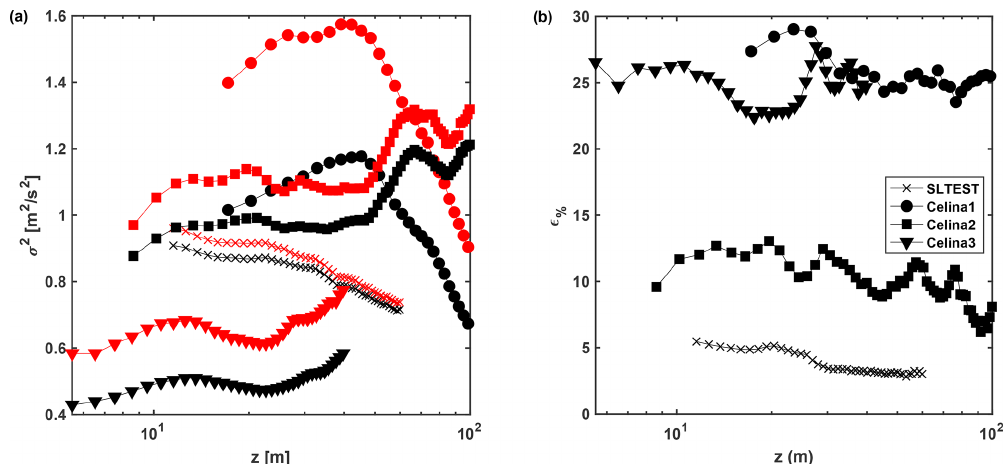
Figure 11. Correction of the second-order statistics: (a) variance before (black) and after (red) the lidar spectral correction and (b) percentage increment of the velocity variance( (cid:15) % ) achieved with the lidar spectral correction.